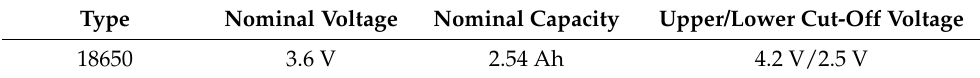
Table 1. Basic specifications of battery.